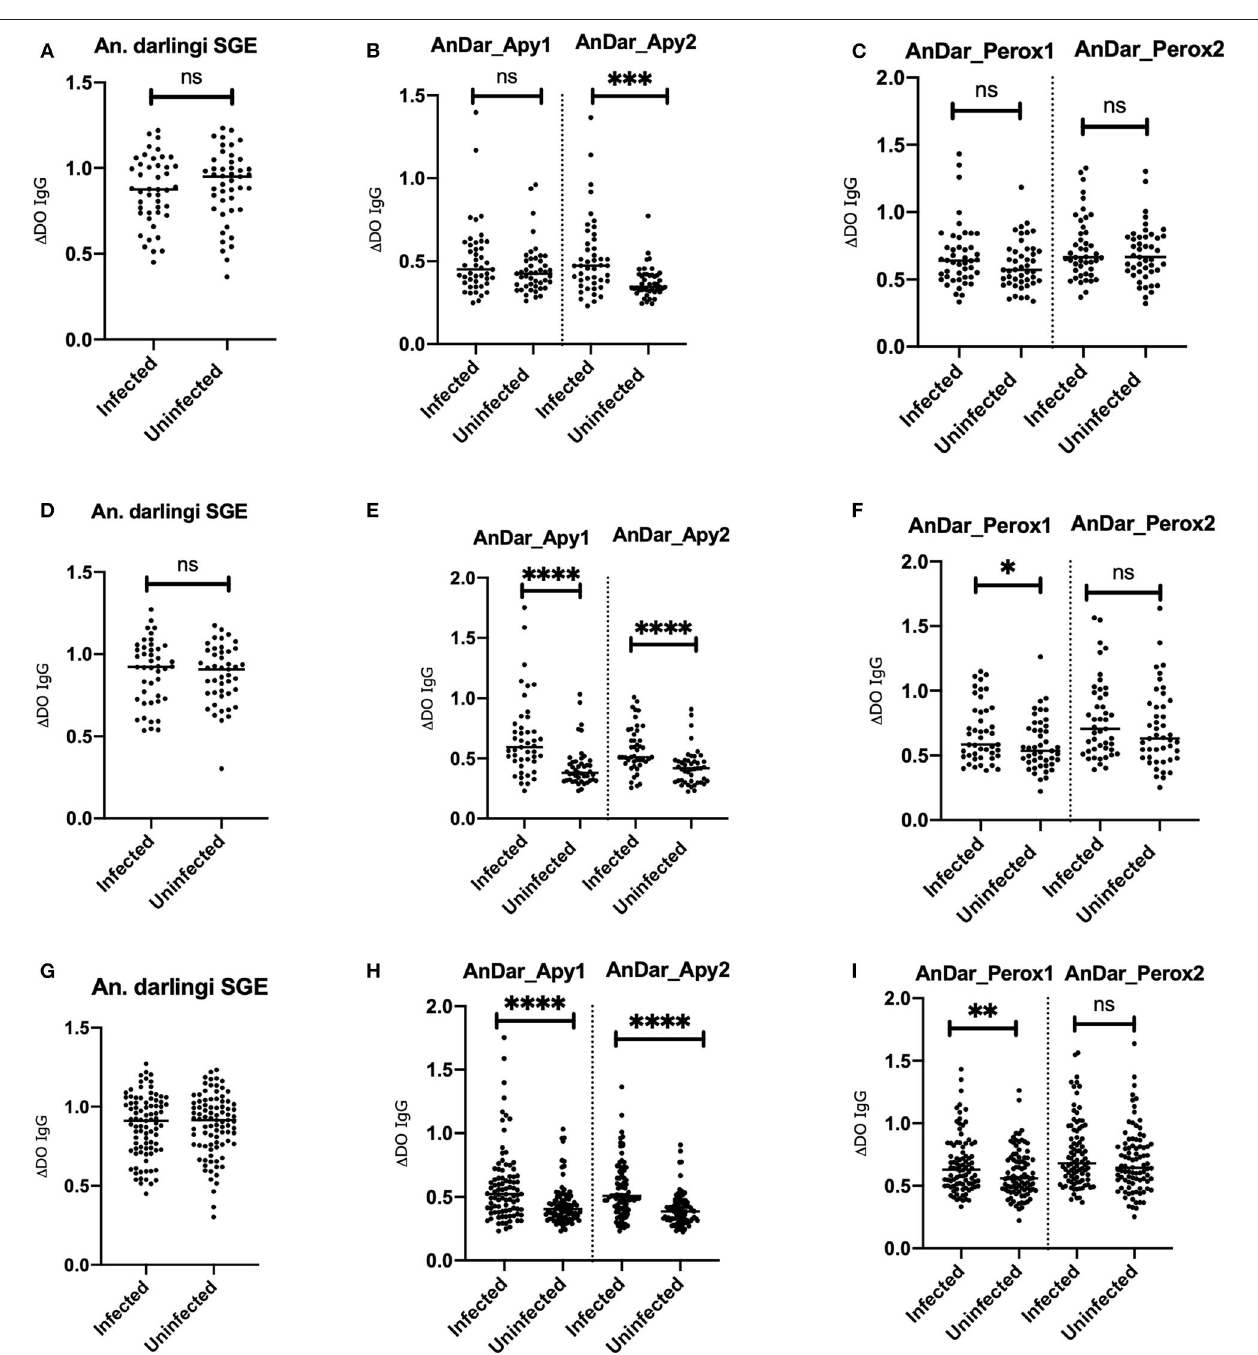
FIGURE 3 | Comparison of IgG antibody levels against An. darlingi salivary antigens in samples with malaria infections and uninfected samples from Turbo (A–C) , El Bagre (D–F) and both sites combined (G–I) . ns denotes not significant, p < 0.05 (* = 0.01 to 0.05, ** = 0.001 to 0.01, and *** = 0.0001 to 0.001).